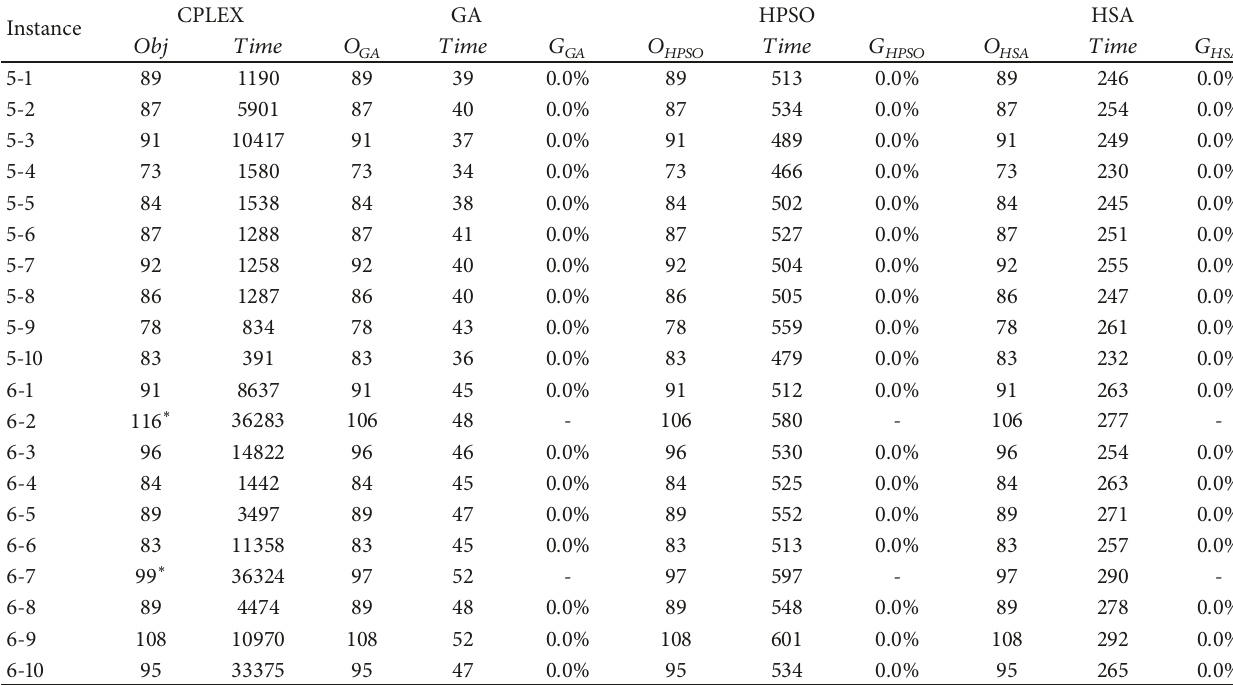
Table 4: Experimental comparison of CPLEX and the heuristic algorithms for small instances.